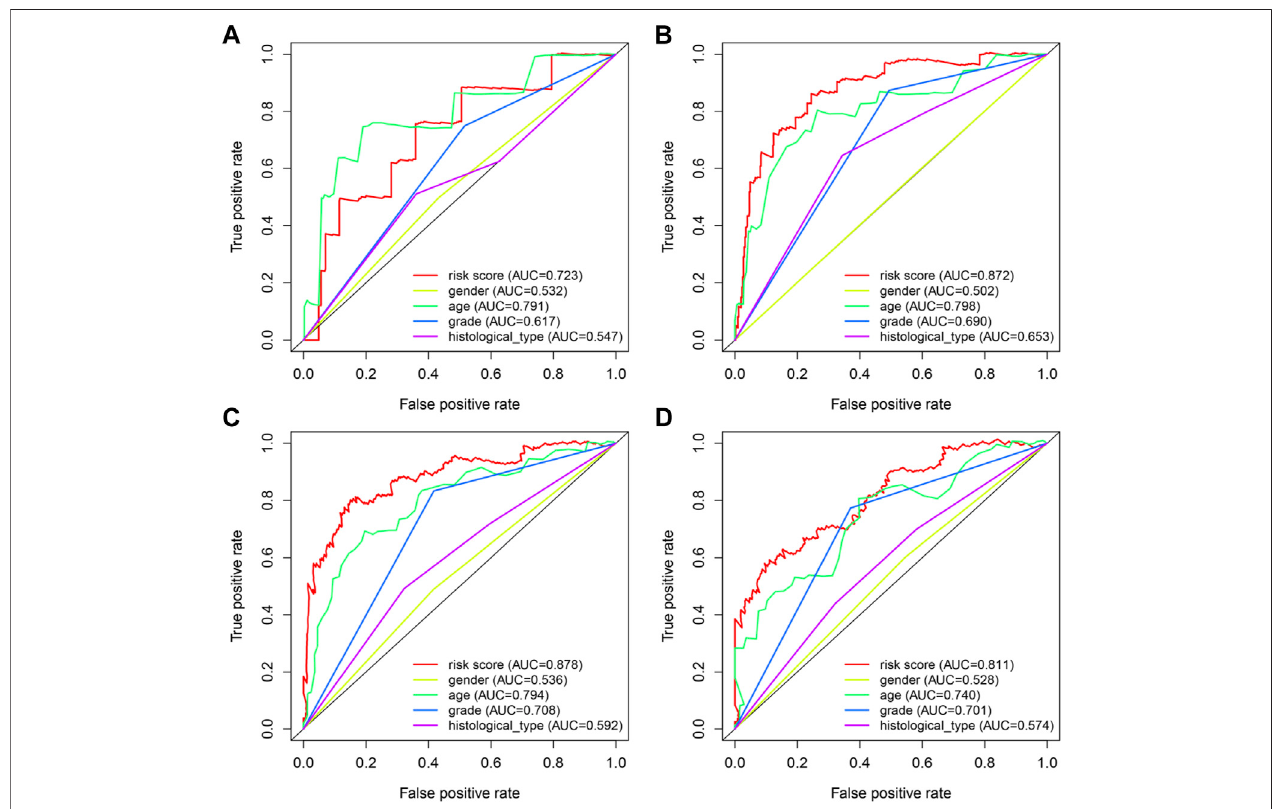
FIGURE 7 | ROC curves of predicting survival. (A) 0.5-year ROC curve (B) 1-year ROC curve (C) 3-year ROC curve (D) 5-year ROC curve AUC: area under the curve. The larger AUC is, the more accurate it predicts.